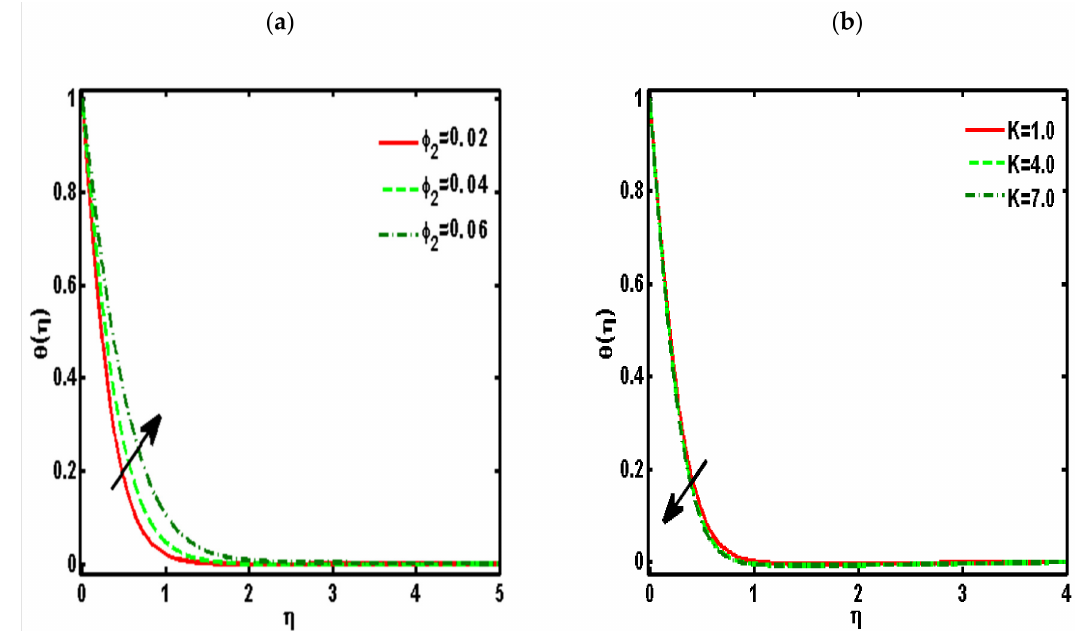
Figure 5. Effects of the ( a ) nanoparticle volume fraction ( φ 2 ) and ( b ) dimensionless viscosity ratio ( K ) on temperature profile θ ( η ) . ( Pr = 6.2, a = 0.5, c = 0.5).